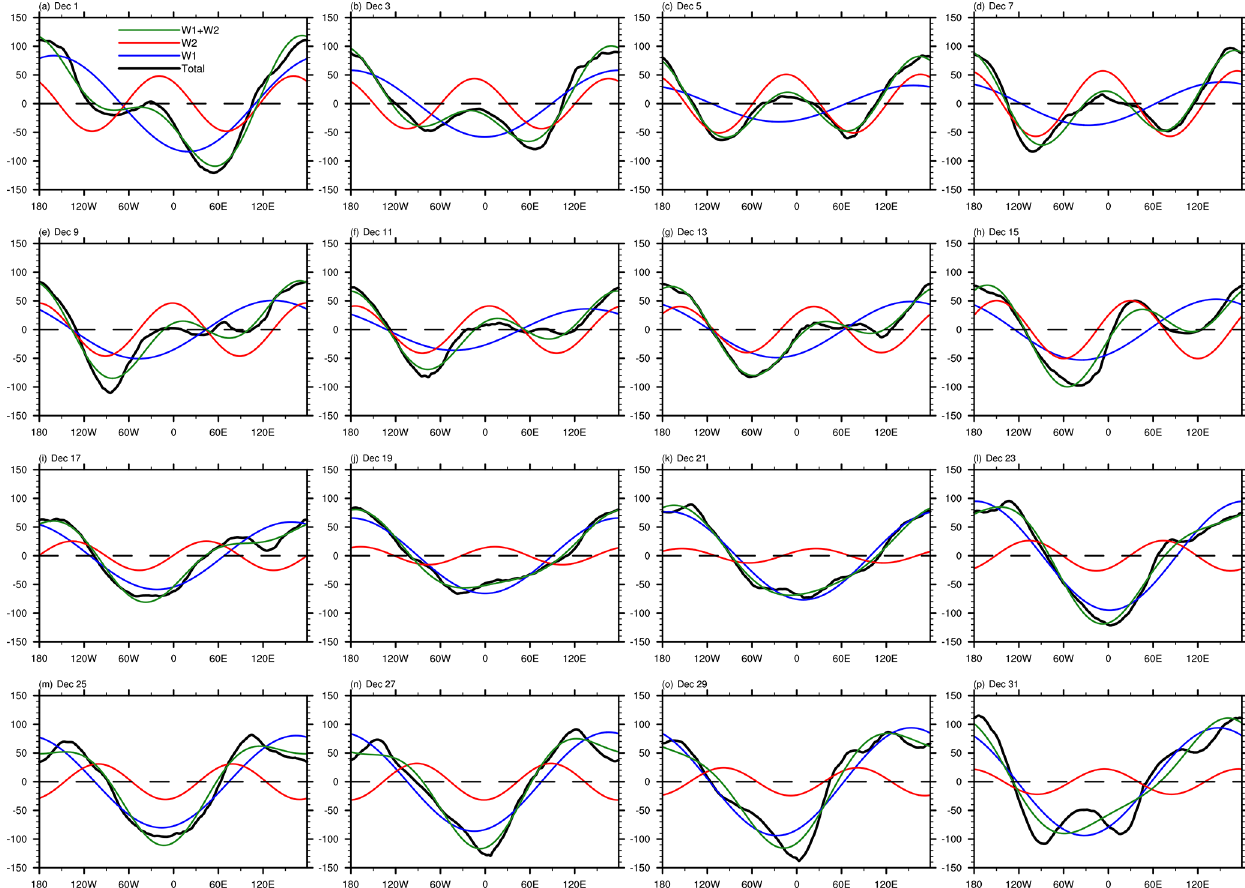
Figure 6. Longitudinal distributions of geopotential amplitudes of PWs for 1–31 December 2014 (shown on every other day; black: total; blue: PW1; red: PW2; and green: PW1+PW2).